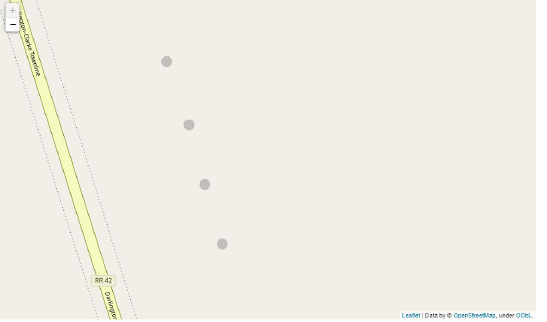
Figure 18. The container placements visualized using Folium and OpenStreetsMap template. The distance between the containers is evenly spaced across the row, ensuring harvesters will have a container near them.